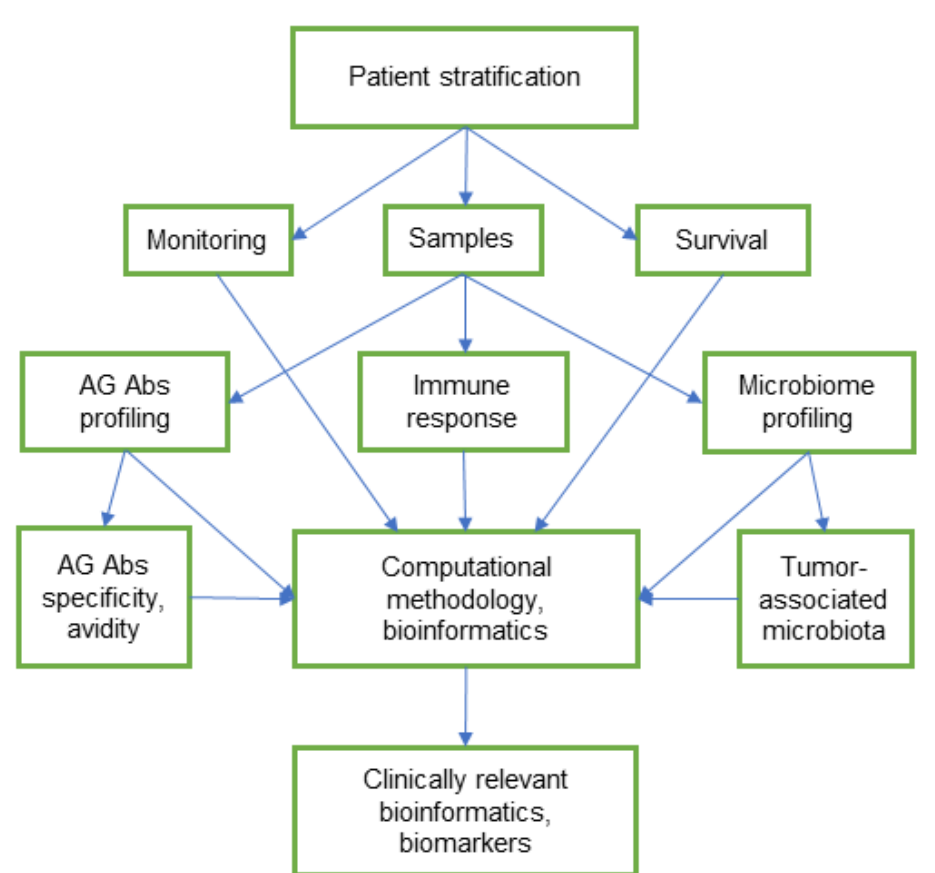
Figure 2. Conceptual scheme of integrative and clinically relevant studies of AG Abs and microbiome in cancer. Patient stratification by tumour localisation and histology, genomic mutations (tissue and liquid biopsies), and response to treatment (chemo/radiotherapy, immunotherapy, and targeted therapy). Monitoring by tumour markers (CEA, CA 19-9, CA 72-4, M2-PK), liquid biopsy, and commonly used clinical parameters. Survival: overall and cancer-specific survival. Samples: serum, plasma, and saliva for the AG Abs profiling; tumour tissues, saliva, and faeces for the microbiome profiling; tumour tissue and blood to assess the immune response. AG Abs profiling: using the glycan microarrays, differentiation of auto-AG Abs and Abs against microbiota. AG Abs specificity and avidity: affinity chromatography, surface plasmon resonance, modified and competitive ELISA. Microbiota profiling by 16S rRNA gene amplicon analyses and PCR. Tumour-associated microbiota: the recognition of beneficial species and pathogens. Immune response: the association with survival of the local immune response (tumour-infiltrating lymphocytes, macrophages, and neutrophils) and systemic response (a count and ratio of immune